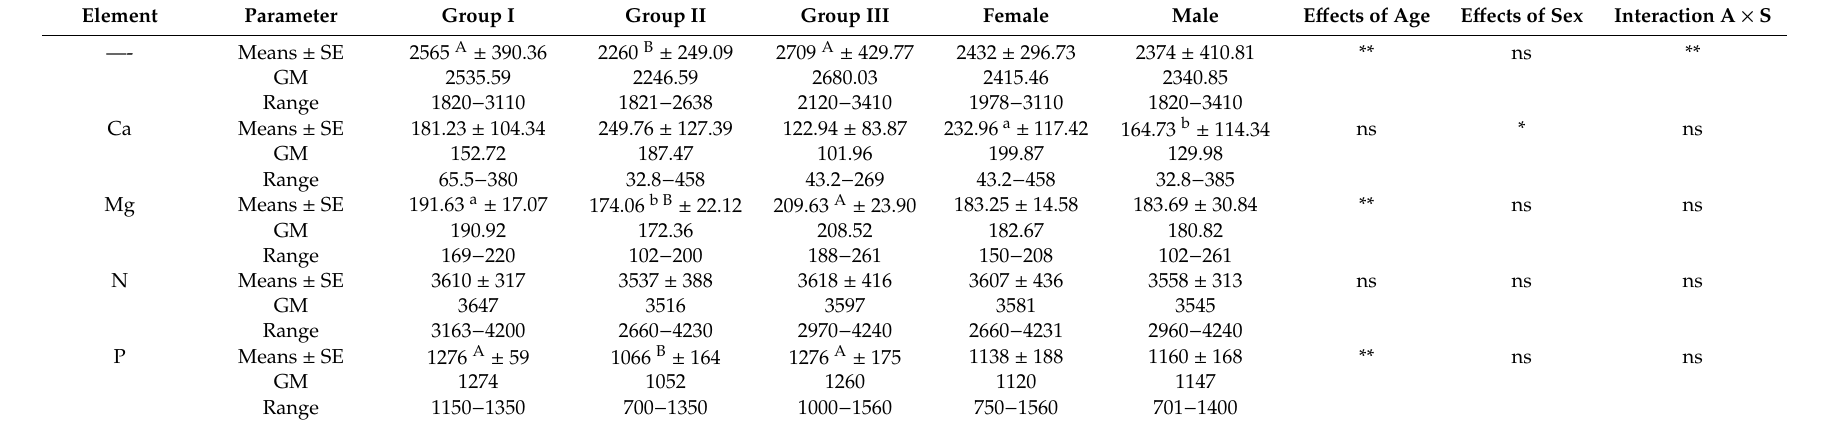
Table 3. Concentration of macroelements in wild boar liver (mg · kg − 1